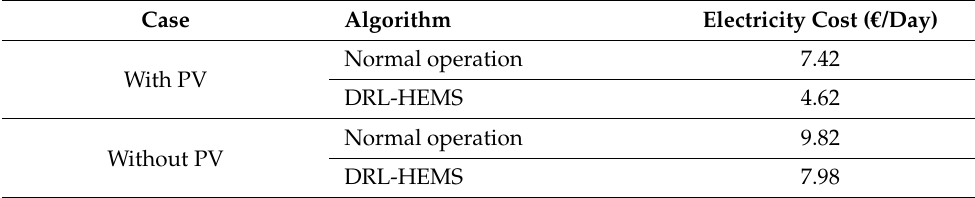
Table 7. The total operational electricity cost for different environments for one day.